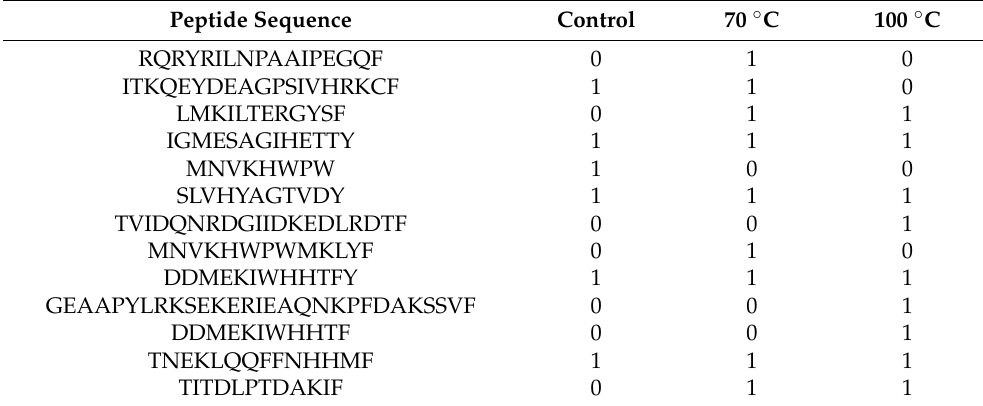
Table 3. The digested peptides of myosin with different heating degrees. Peptide